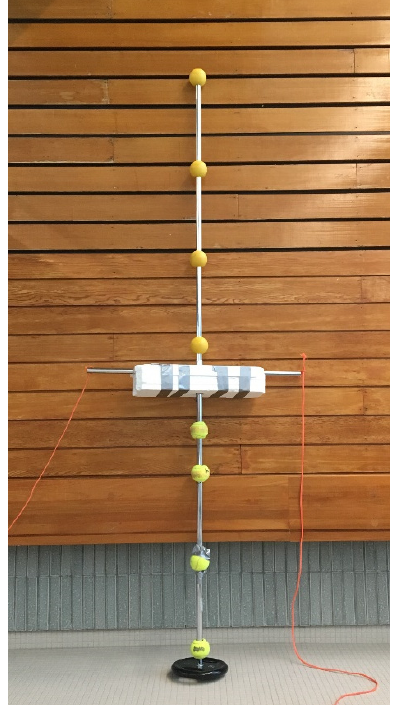
Figure 2. The semi-submersed rigid calibration object consisting of eight bright-yellow balls with fixed distances separated by a polystyrene foam flotation device. Two ropes of polyester were attached to each side at the water level for pulling the calibration object through the swimming pool.